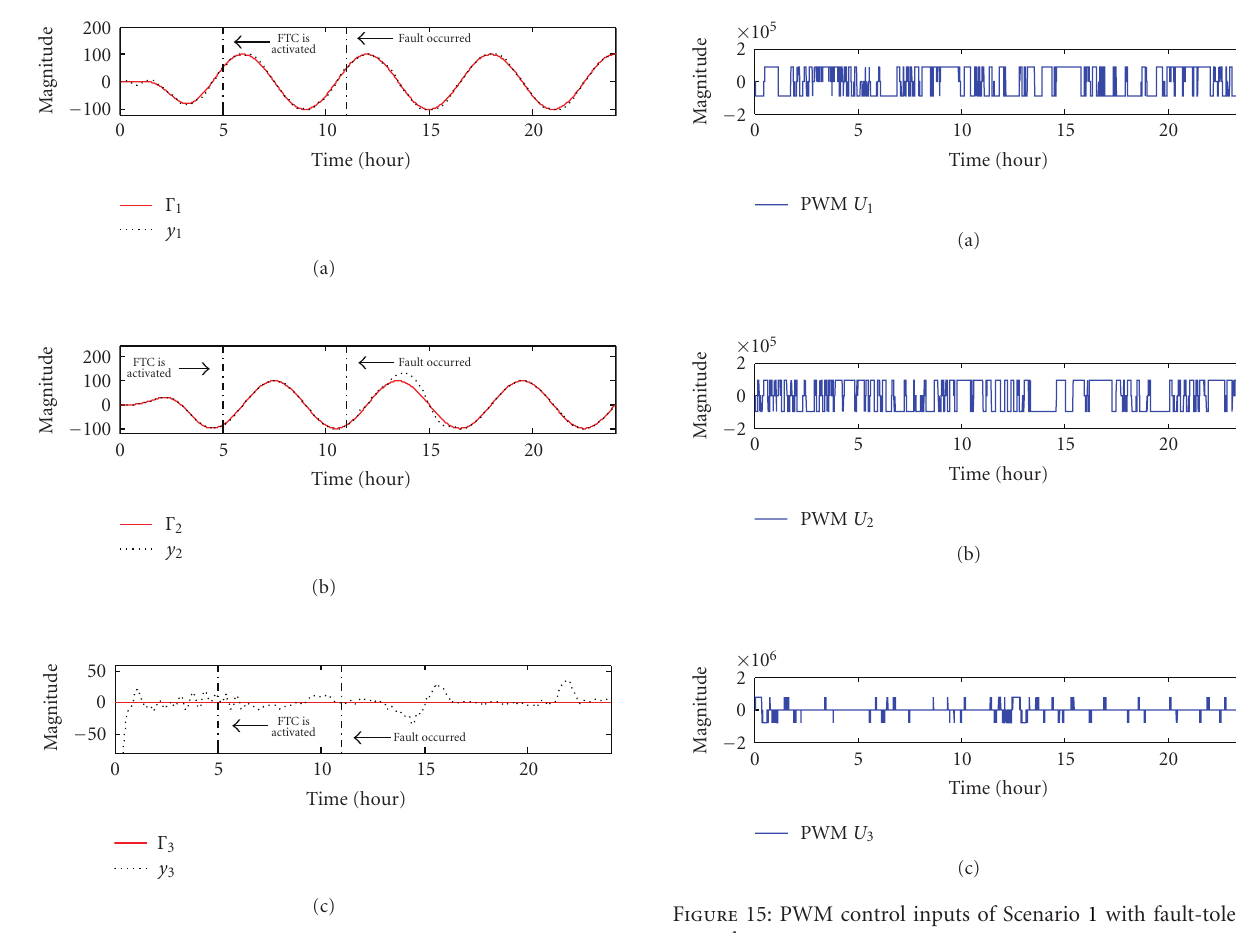
Figure 14: Output responses of Scenario 1 with fault-tolerant control.